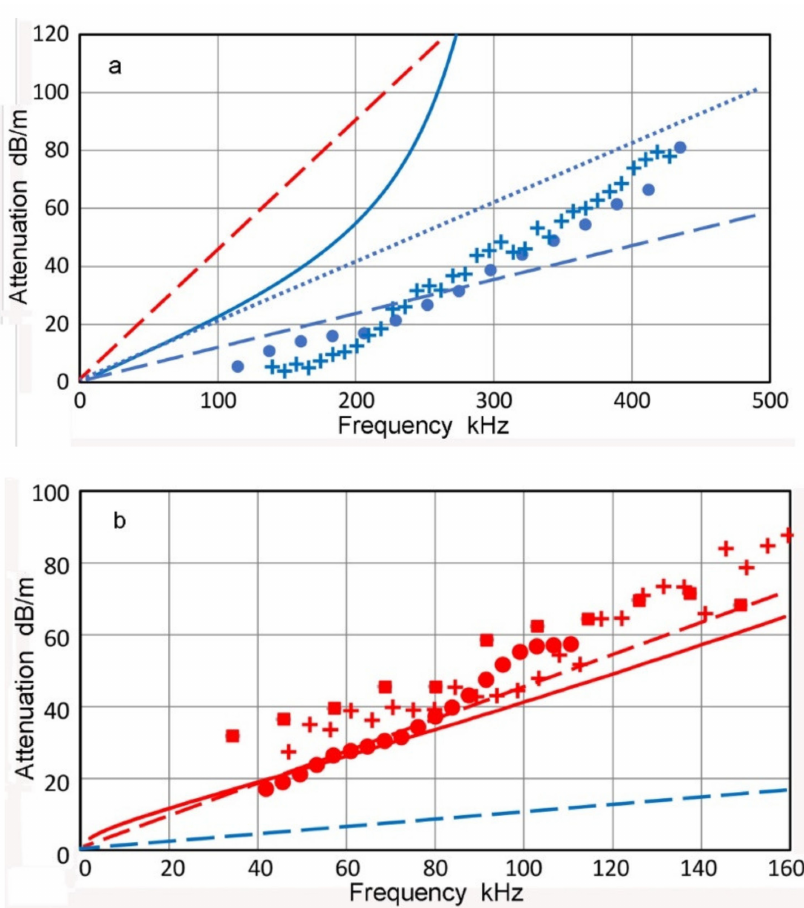
Figure 18. ( a ) Observed α –S o values for 2.3-mm XP-GFRP sheet with the calculated attenuation and dashed lines for α L (= α 33 ) and α T (= α 32 ). Blue dotted line is for α L = α 22 , showing differences in 0 ◦ and 90 ◦ directions. Two test series are plotted using blue symbols. Both used Olympus V101 Tx and KRN-BB-PC Rx. Data with + symbols used short-pulse excitation and dot data used 400-kHz Gaussian pulse. ( b ) Observed α –A o values for 2.3-mm XP-GFRP sheet with the calculated attenuation and dashed lines for α L and α T (= α 32 ). Red dotted line for α T = α 32 is also plotted. Three data series are shown. Red dot data used Olympus V103 Tx and KRN-BB-PC Rx, red square data with AET AC375L Tx and PAC Pico Rx, and red + data with NDT C16 Tx and KRN-BB-PC Rx. All Tx used 60 ◦ incident angle and short-pulse